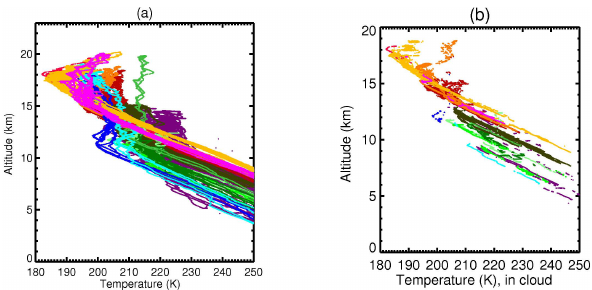
Fig. 4. (a) Temperature and altitude coverage of all data taken dur- ing all campaigns. (b) Same as (a) but for in-cloud data only. The color scheme is the same as in Fig.